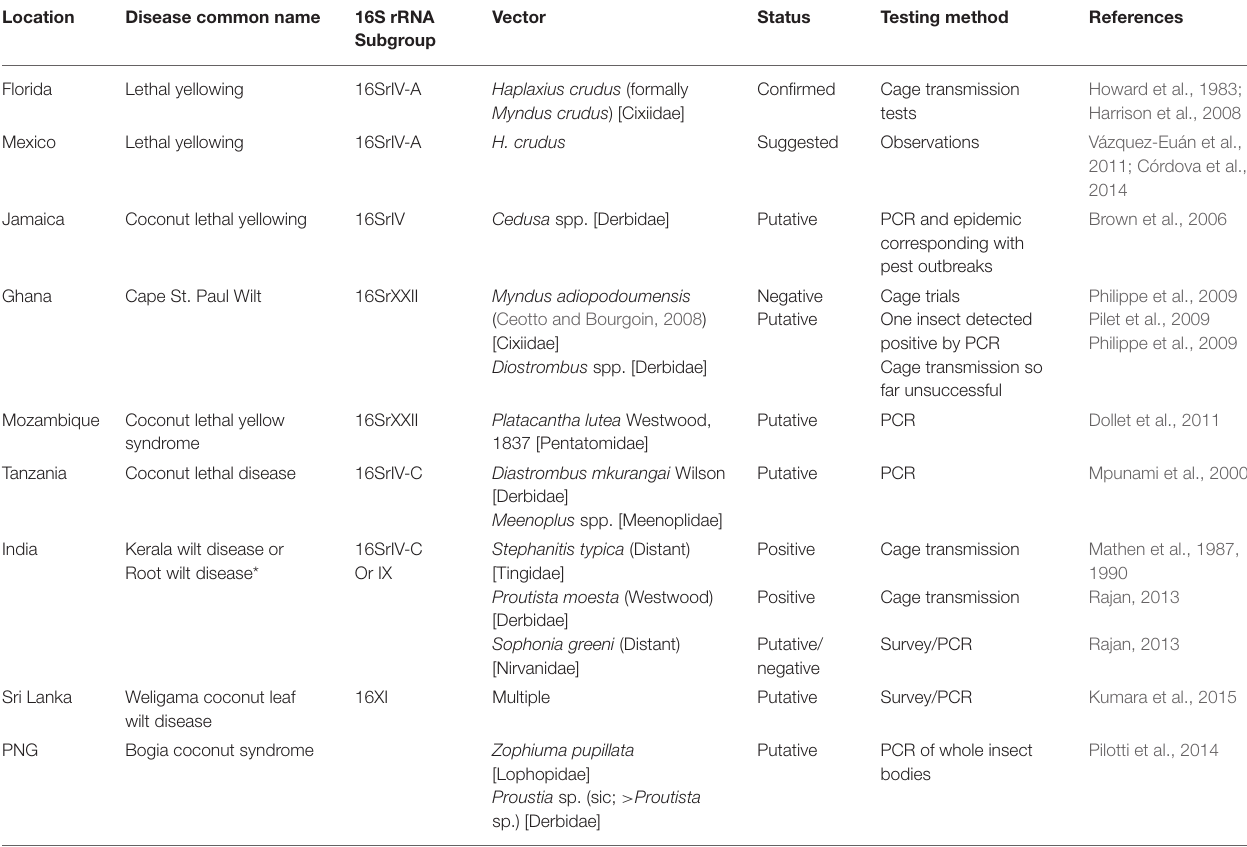
TABLE 3 | Summary of knowledge on plant-phytoplasmas-vector interactions.